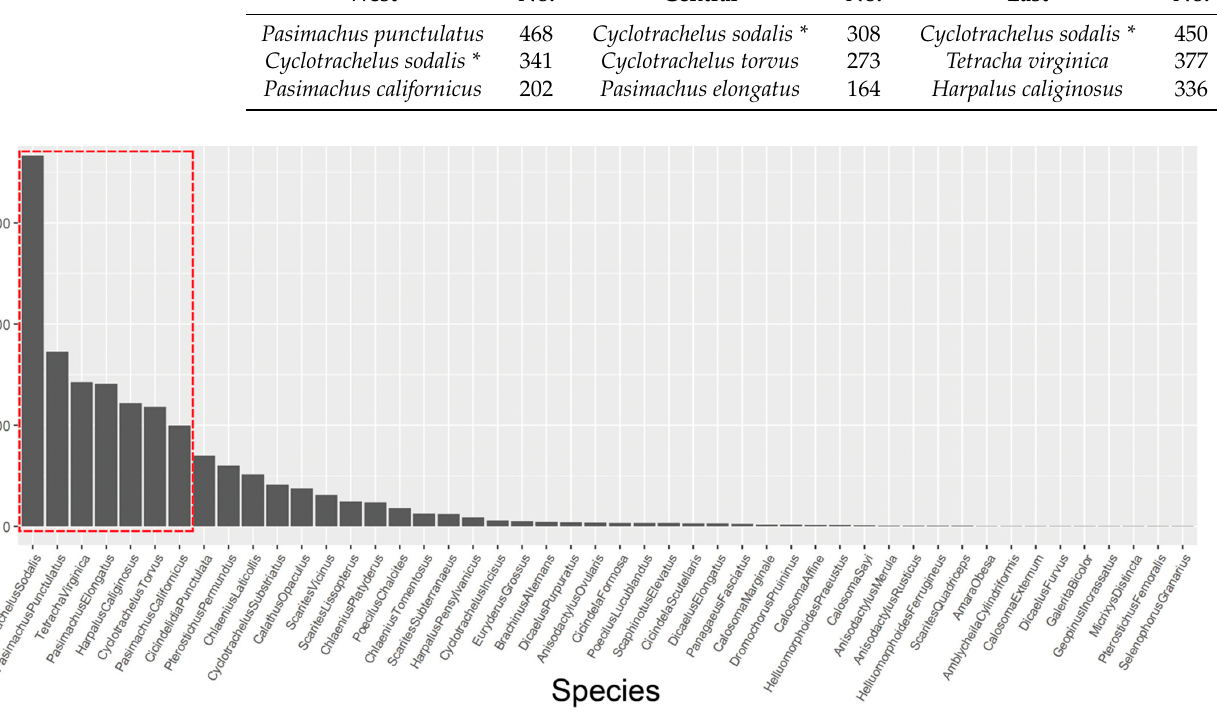
Figure 2. Rank abundance of all 48 restored grassland carabid beetle species from highest to lowest abundance. Seven species (red box) represent 68% of all carabids collected across 108 sites in 2017 and